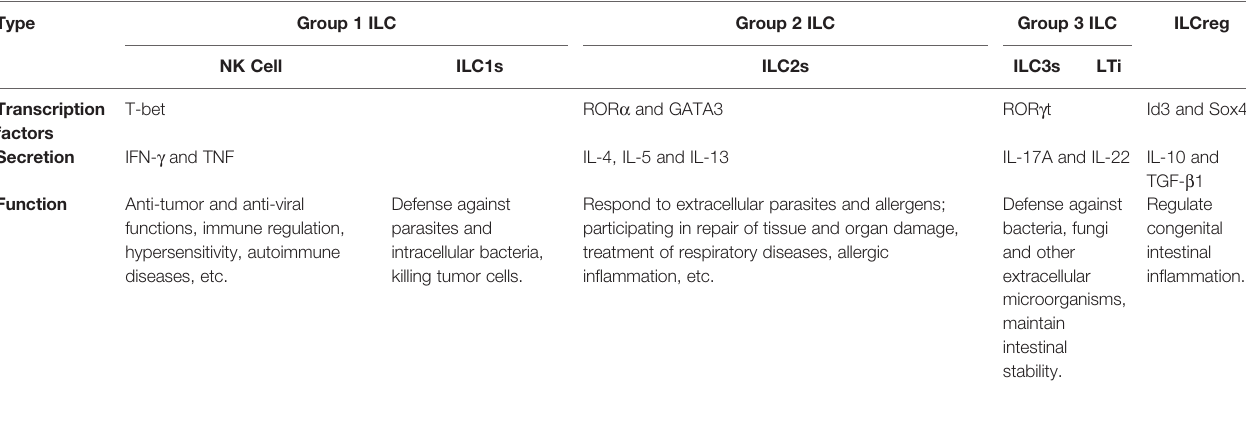
TABLE 1 | Types and functions of the